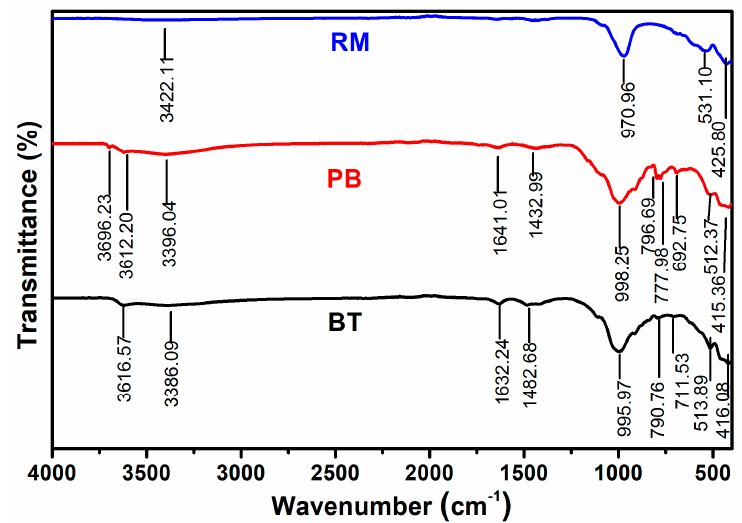
Figure 4. FTIR spectra of RM, PB, and BT adsorbent.